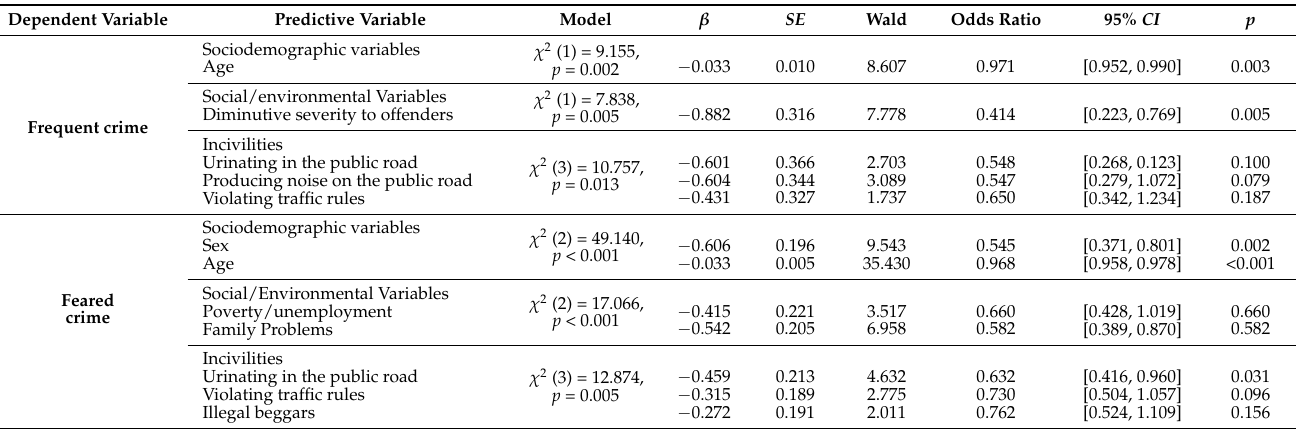
Table 4. Logistic Binary Regression Models examining criminal occurrences (against people vs against